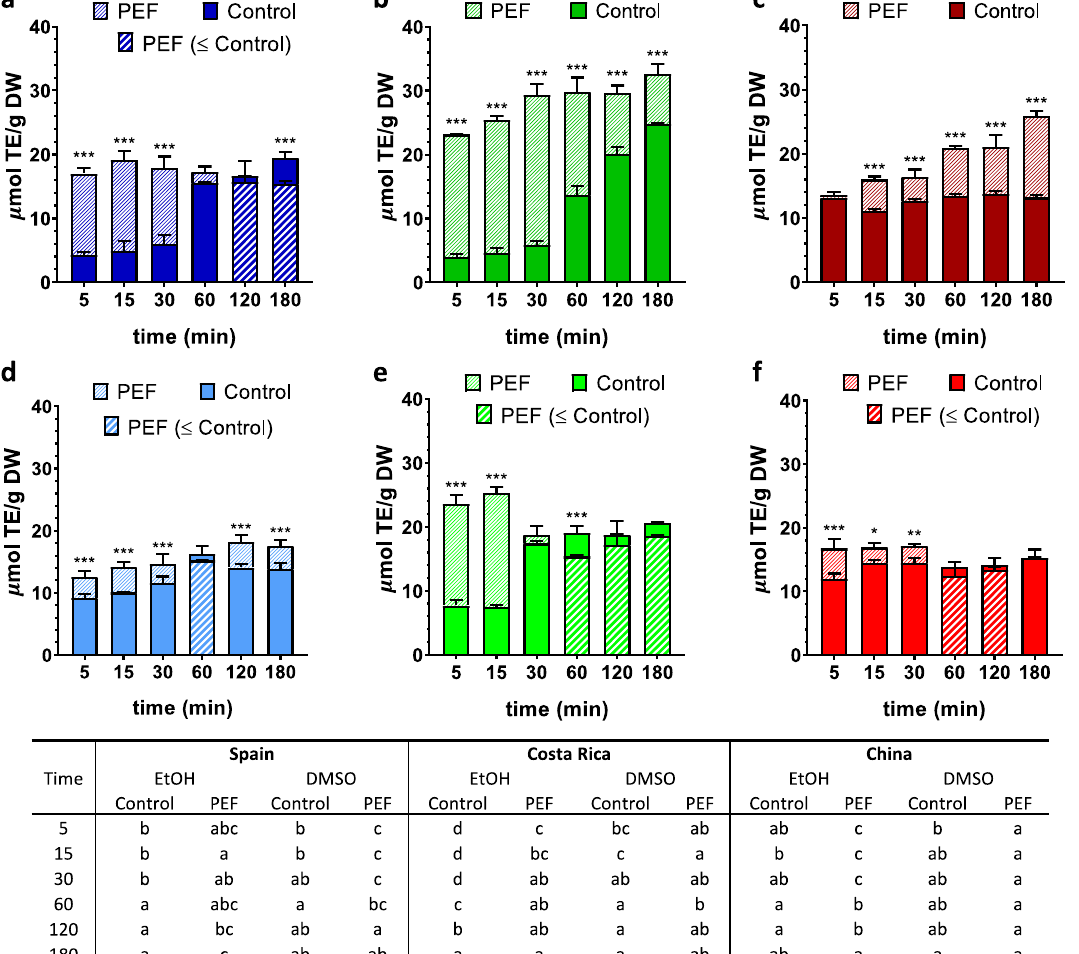
Figure 5. Trolox equivalent antioxidant capacity of Spirulina extracts with PEF treatment or without PEF treatment (Control) for ethanol:water ( a – c ) and DMSO:water ( d – f ) solvent from Spirulina cultivated in different geographical regions (blue: Spain, green: Costa Rica, red: China). Statistical differences related to the PEF treatment are represented by asterisks (*). Statistical differences related to the extraction time are represented by different lower-case letters in the table. * p < 0.05; ** = p < 0.01; *** = p < 0.001.